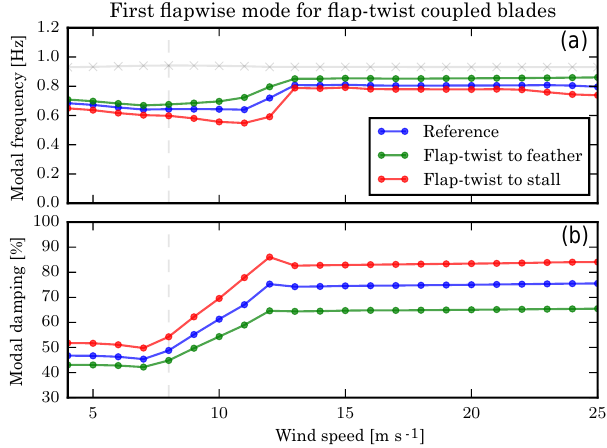
Figure 9. Aeroelastic frequency (a) and damping ratio (b) over the operational wind speed range of the first edgewise blade-only mode for the reference and edge–twist coupled blades with coupling co- efficients of γ x = ± 0 . 1. The grey solid lines indicate other blade modes of the reference blade. The grey dashed line indicates the pretwisting reference speed of 8ms − 1 .